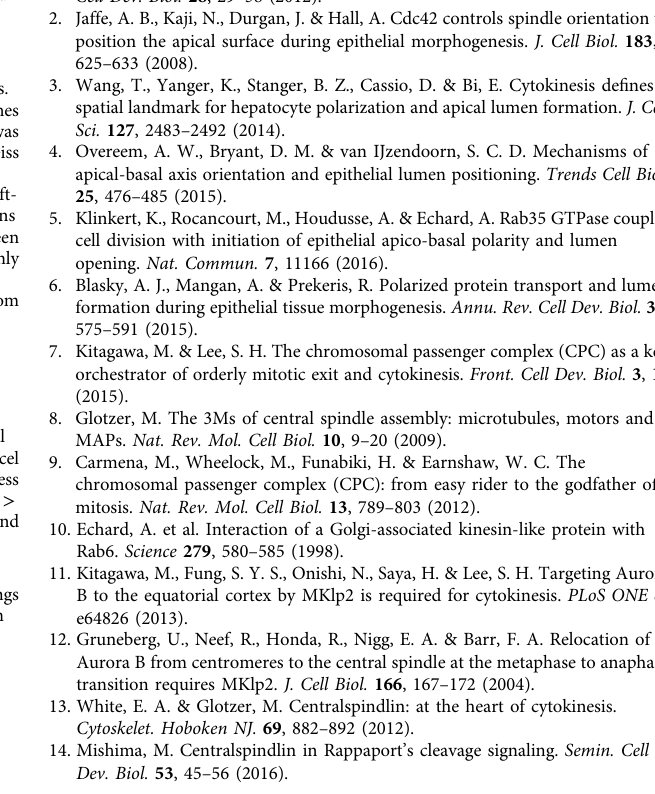
Fig. 6 Molecular model for IFT function in central spindle organization, symmetrical cleavage furrow ingression and lumen positioning. IFT88 is depicted in this model as a component required for a timely and uniform relocalization of the Aurora B/MKLP2 complex to the central spindle through its interaction with MKLP2. It is thus essential for the relocalization of MKLP1 and MgcRacGAP, which are required for proper central spindle MTs assembly. By ensuring a timely and uniform distribution of cytokinetic regulators across the central spindle, including the localization of the small GTPase RhoA, IFT proteins spatially control symmetrical cleavage furrow ingression. Given that cytokinesis provides the spatial landmark for de novo-formed lumen, IFT88 would be required for proper lumen positioning in two-cell stage 3D cultures by controlling the geometry of cleavage furrow color combining and measurements) were performed with ImageJ or Imaris (Bitplane). Linescans were obtained using ImageJ plot pro fi le tool. MKLP1,